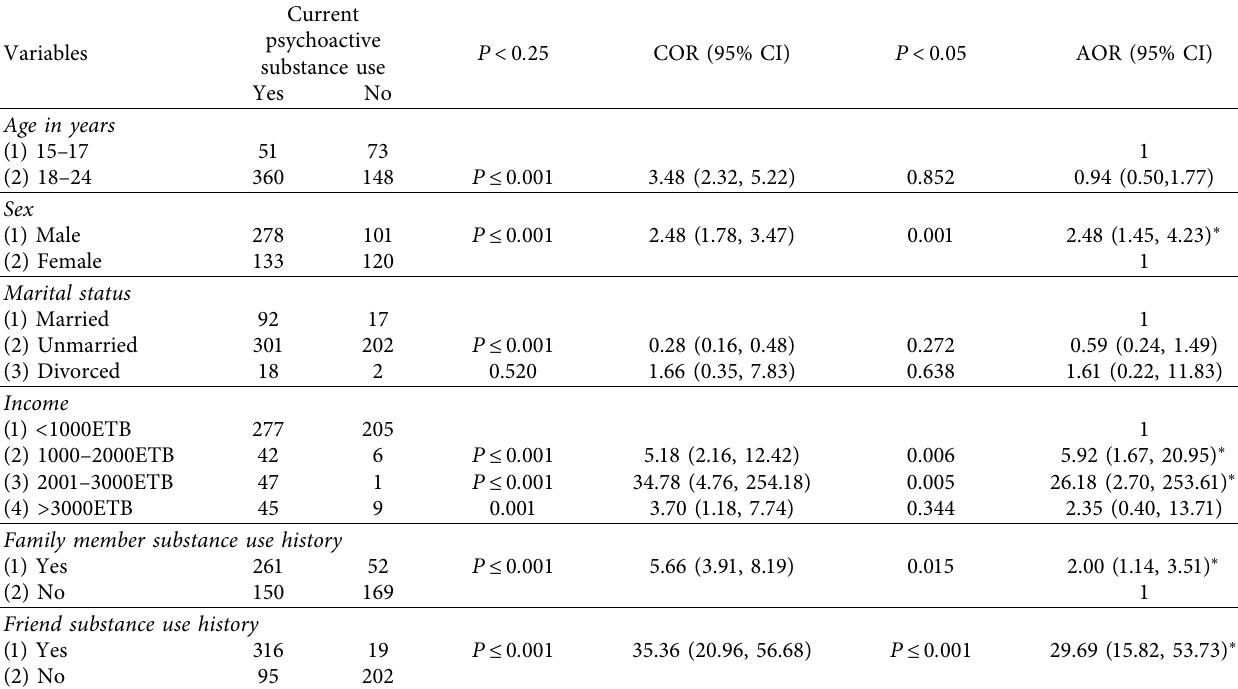
Table 3: Factors associated with current psychoactive substance use among youths of age 15–24 years at three selected administrative towns, North Shewa Zone, Amhara regional state, Ethiopia, 2020 ( n �